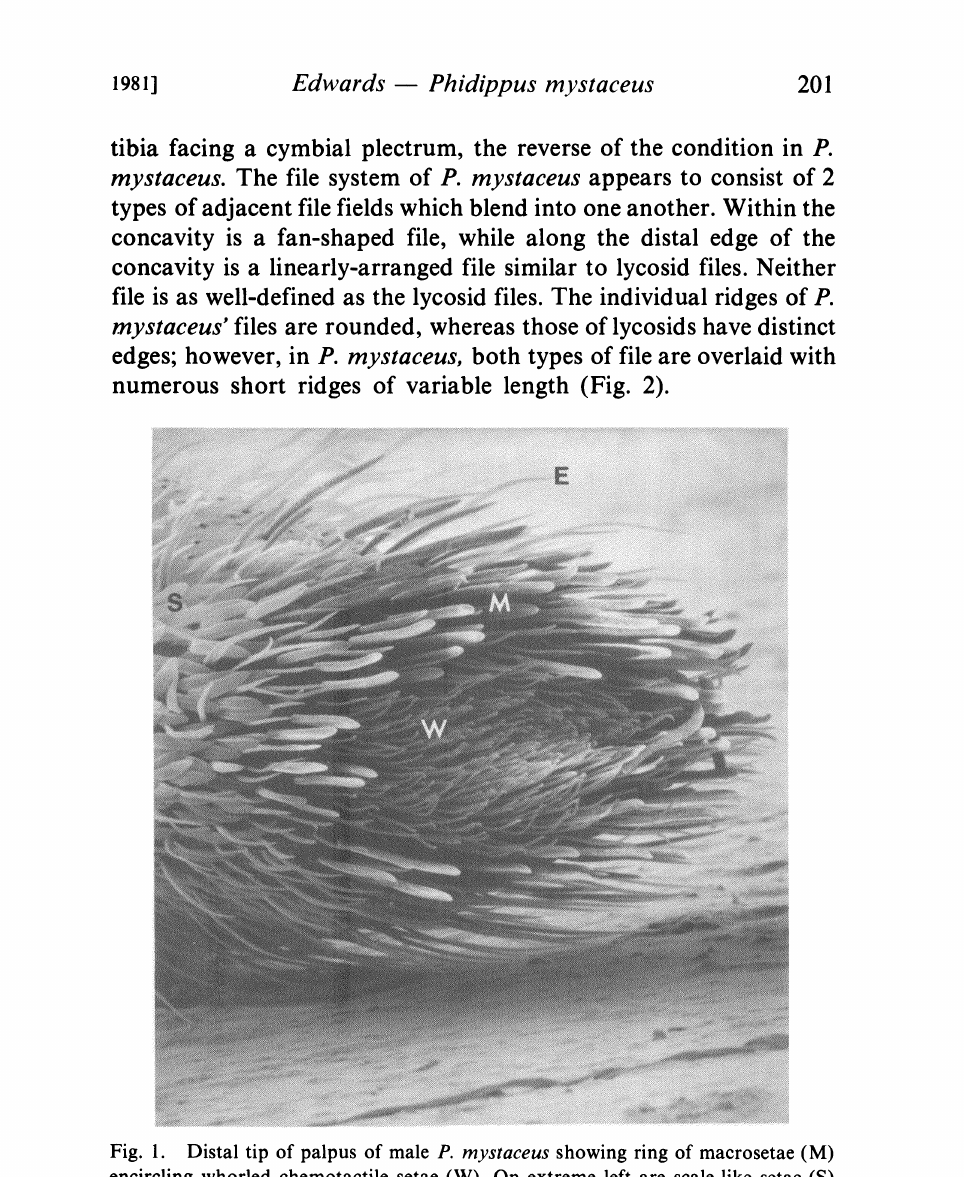
Fig. 1. Distal tip of palpus of male P. mystaceus showing ring of macrosetae (M) encircling whorled chemotactile setae (W). On extreme left are scale-like setae (S) which form part of a white and/or yellow spot which probably contributes to the overall visual stimulus of a courting male (100X). Note the greater number of macrosetae on the ectal edge (E); see text for explanation. The curved macrosetae (extreme right) at the tip of the cymbium first contact the substrate and may facilitate the backwards sliding motion of the palpi by reducing friction with the